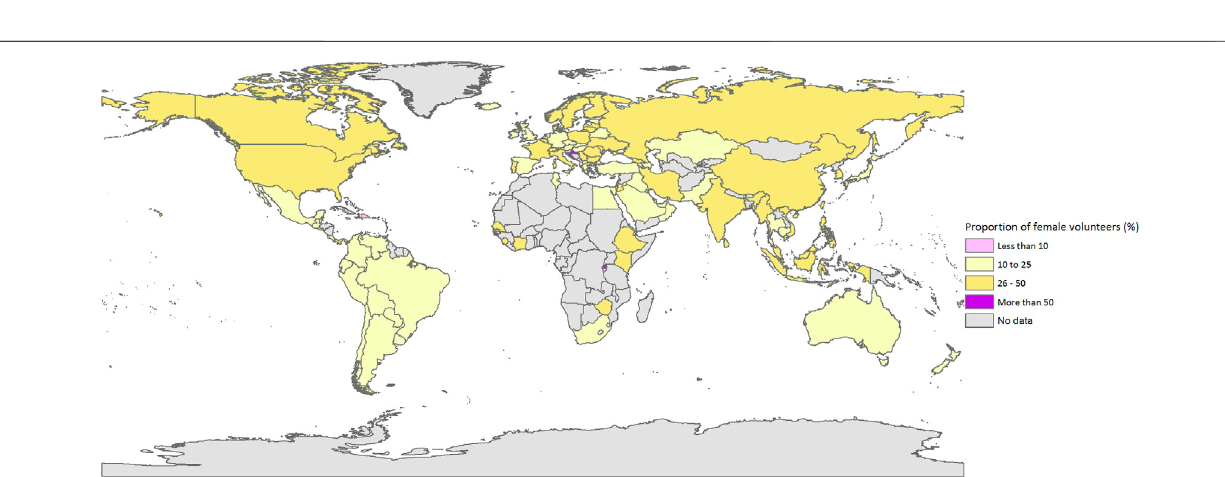
FIGURE 6 | Time of fi rst contribution, when volunteers make their fi rst, and for many their only, classi fi cation.